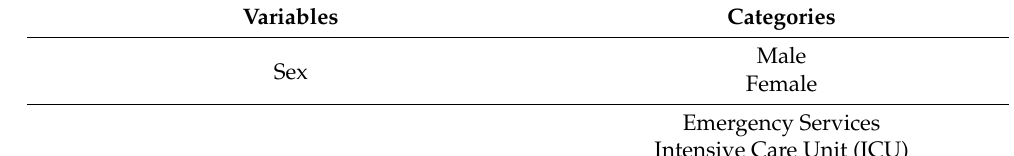
Table 6. Variables and categories in the MCA.